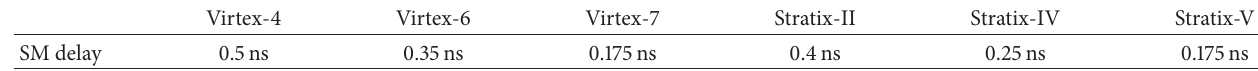
Table 1: Switch matrix (SM) delay of select FPGA families.